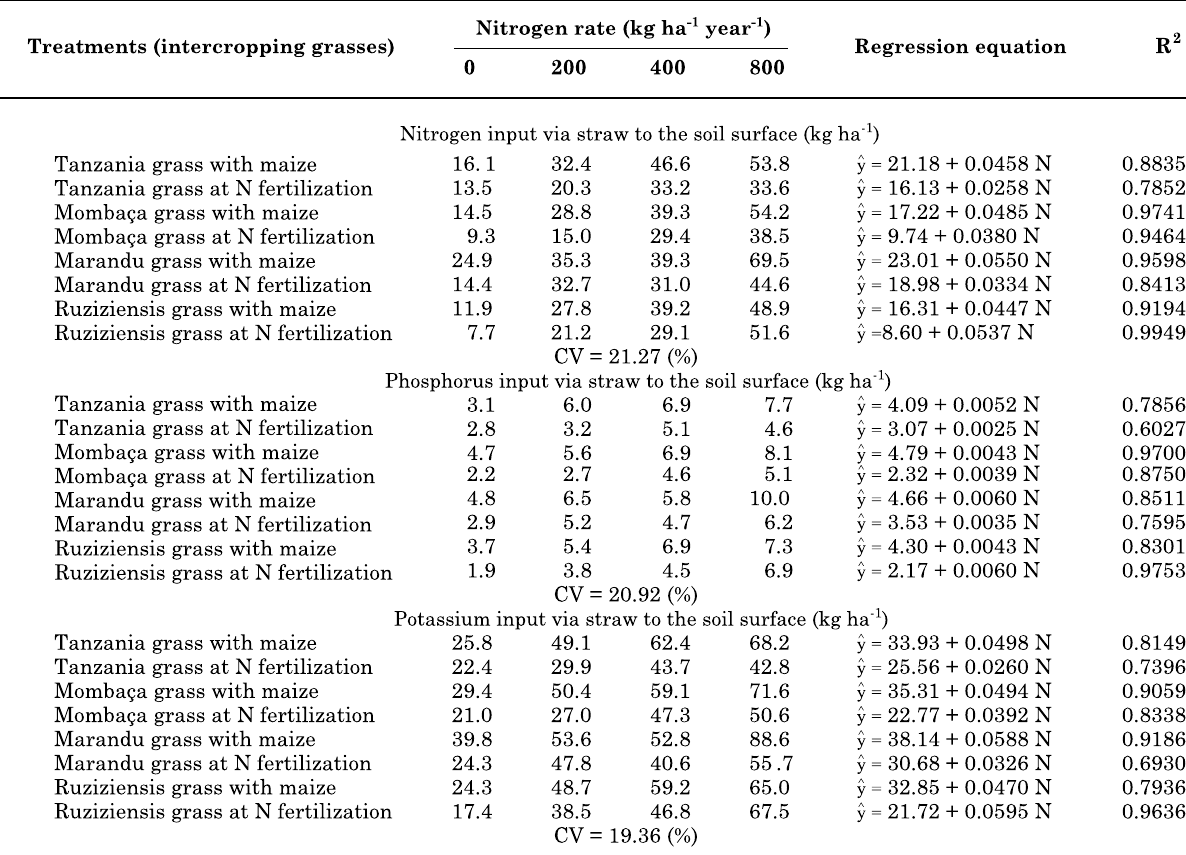
Table 1. Nitrogen, phosphorus and potassium input via straw to the soil surface of Panicum maximum cv. Tanzânia, Panicum maximum cv. Mombaça, Brachiaria brizantha cv. Marandu and Brachiaria ruziziensis grown intercropped with maize, N-fertilized (divided in four cuts) and chopped after the last cut in winter/spring. Selvíria-MS.